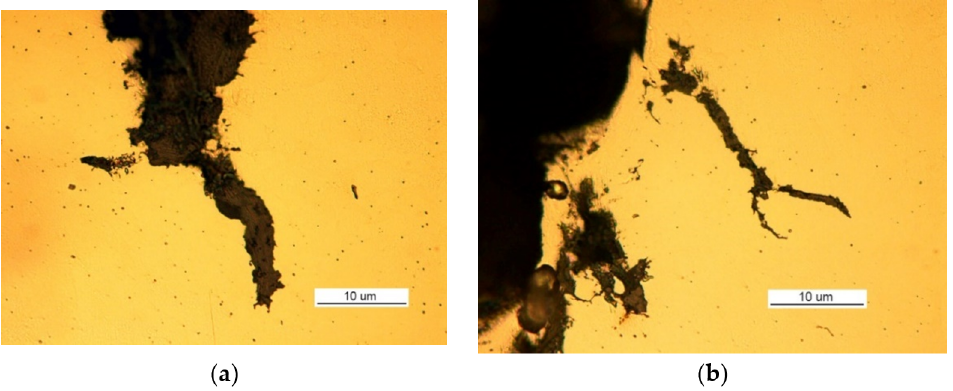
Figure 38. Optical microscopy views (handy-size bulk carrier 30185 DWT): ( a ) the front of the crack developing in part 1 and ( b ) secondary cracks filled with corrosion